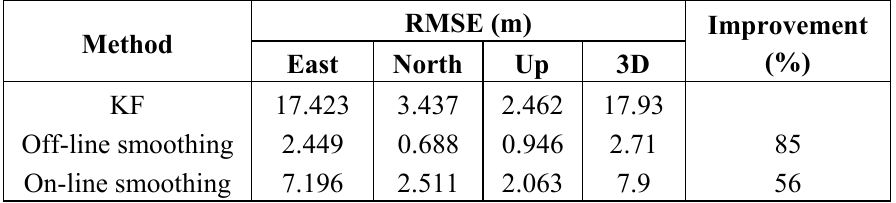
Table 3. Comparison of three estimation strategies in terms of positional error.